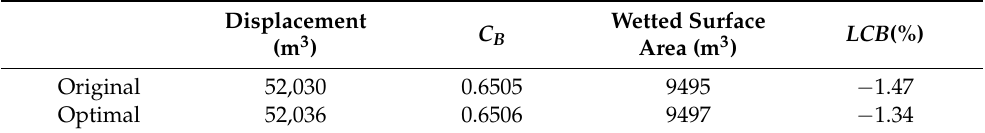
Table 9. Comparison of hydrostatics between original and optimal hull